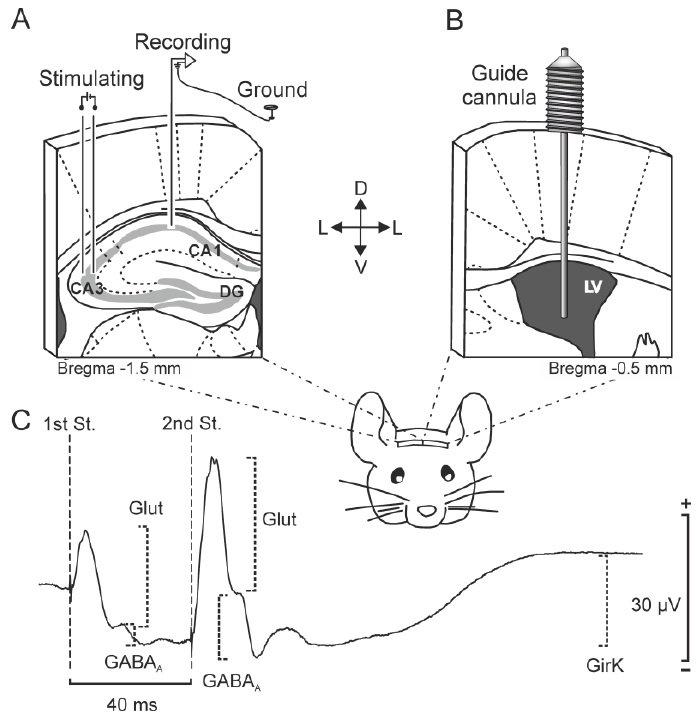
Figure 1. Experimental design. ( A ) The picture illustrates how mice were prepared for chronic recording of fEPSPs evoked at the hippocampal CA3–CA1 synapse, by surgical implantation of bipolar stimulating electrodes on the right Schaffer collaterals, and bipolar recording electrodes at ipsilateral CA1 region. A bare silver wire was fixed to the skull to act as ground. ( B ) The picture illustrates how mice were implanted with a stainless-steel guide cannula for drug administration. The cannula was implanted on the left ventricle, contralaterally to both electrodes, in order to preserve the functionality of CA3–CA1 synapse. ( C ) Representation of the fPSPs evoked in the CA1 hippocampal region after paired-pulse stimulation (interval of 40 ms) of the Schaffer collaterals. The recording was obtained from a representative animal and illustrates the averaged ( n = 50) profile of the postsynaptic response. Three different components were identified for amplitude analysis: (1) a glutamatergic fEPSP, with a latency of appearance of 2.25–4 ms after stimulation, (2) a GABAergic fIPSP dependent on GABA A receptors, with a latency of 12–15 ms, and (3) an fIPSP dependent on metabotropic receptors and GirK channels, with a latency of 26–36 ms. For each component or postsynaptic potential, the maximum amplitude (peak-to-peak value) was measured for the analysis. LV, Lateral Ventricle; DG, Dentate gyrus; St., stimulus; D, dorsal; M, medial; L, lateral; Glut,